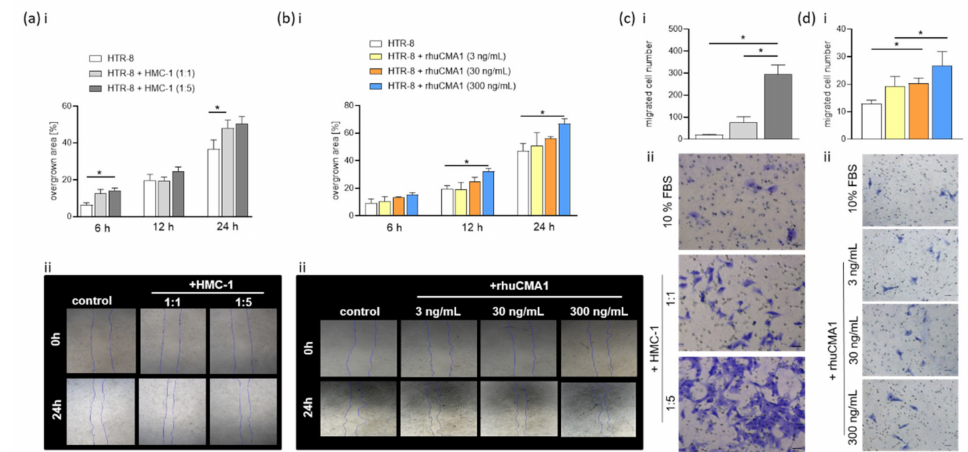
Figure 5. Both HMC-1 and rhuCMA1 increase HTR-8/SVneo migration. The overgrown scratch area ( a ( i )) or number of migrated ( c ( i )) HTR-8/SVneo cells cocultured with HMC-1 cells (HTR-8: HMC-1 ratio 1:1 and 1:5) or rhuCMA1 ( b ( i ), d ( i )) at 6/12/24 h. The results are presented as a mean with SEM. Statistical analysis was performed using one-way ANOVA (* p < 0.05). Representative images are shown in (( a ( ii ), b ( ii ), c ( ii ), d ( ii )), scale bar 200 µ m). HTR-8: HTR-8/SVneo; rhuCMA1: recombinant human